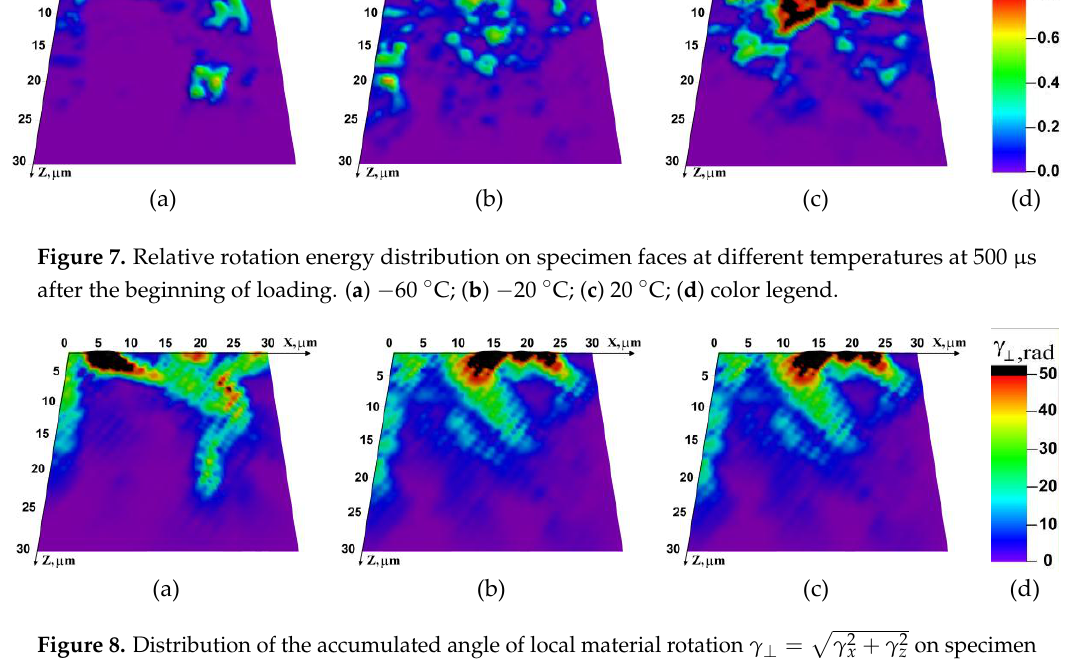
(cid:112) γ 2 x + γ 2 z on specimen